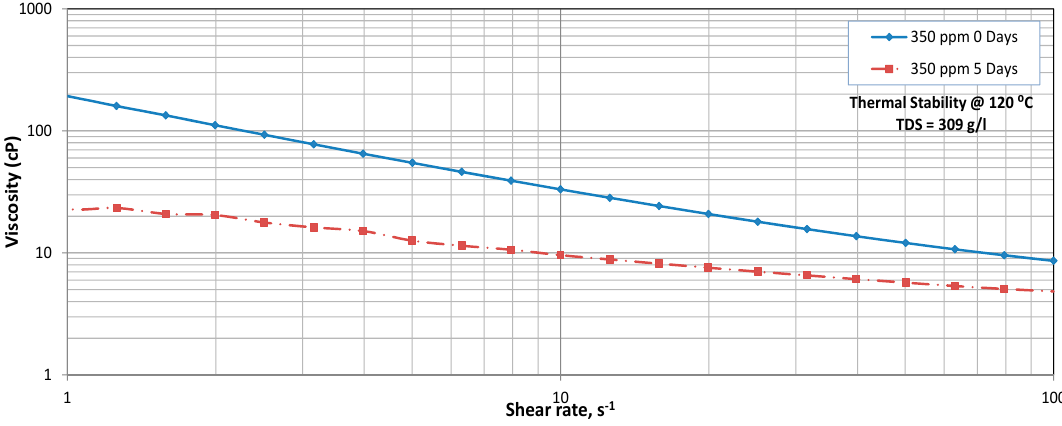
Figure 4. Effect of thermal exposure on biopolymer solution viscosity (SAMA). Figure 4. E ff ect of thermal exposure on biopolymer solution viscosity (SAMA). Brine TDS = 180 g / L.